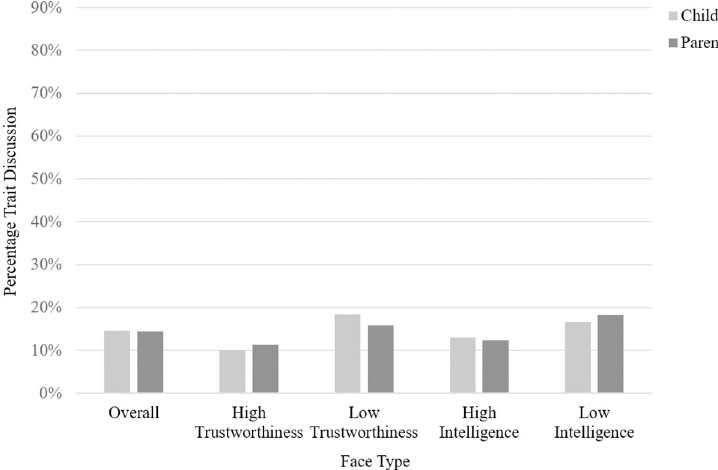
Fig 5. Study 2: Bar graph showing the percentage of parent and child conversation dedicated to trait talk, shown overall and separated by face type.